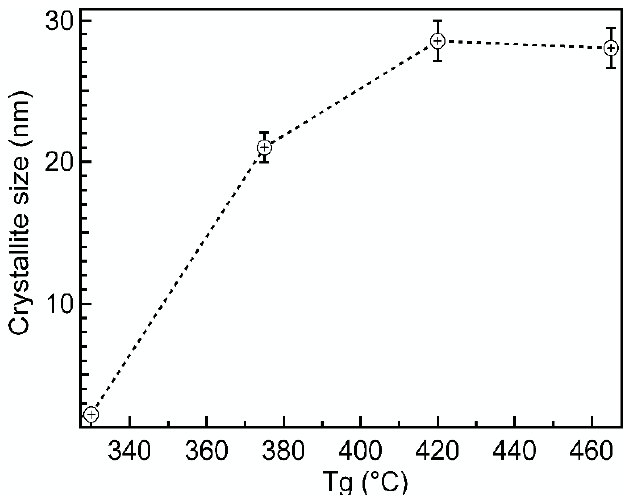
Figure 5. X-ray apparent crystallite size (D v ) in variation of deposition temperature (T g ) for Cr 2 O 3 films. The thickness of the films was in the range of 68–85 nm.